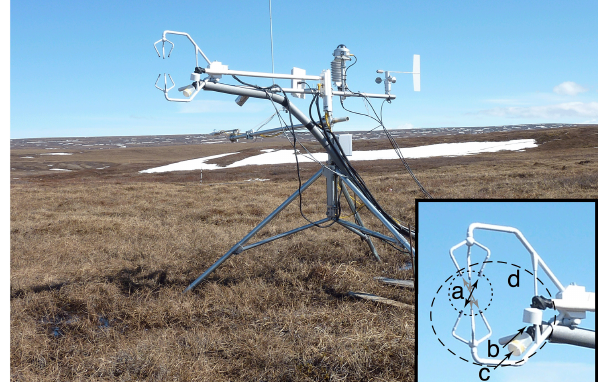
Figure 1. Example of an eddy covariance flux system in the low Arctic, Toolik Field Station, Alaska. The inset shows the ultrasonic anemometer’s sensor head (a) with two inlets of tubes leading air to (b) an enclosed-path CO 2 and H 2 O analyzer, and (c) to a closed- path CH 4 analyzer. The ultrasonic anemometer has three pairs of sensors (pairs shown by arrows), in a configuration that allows for measurement of the three-dimensional wind vector in the air volume indicated by (a) . Due to sensor separation between wind vector and gas concentration measurements, the eddy covariance “point” mea- surement is representing a somewhat larger volume of air indicated by (d)